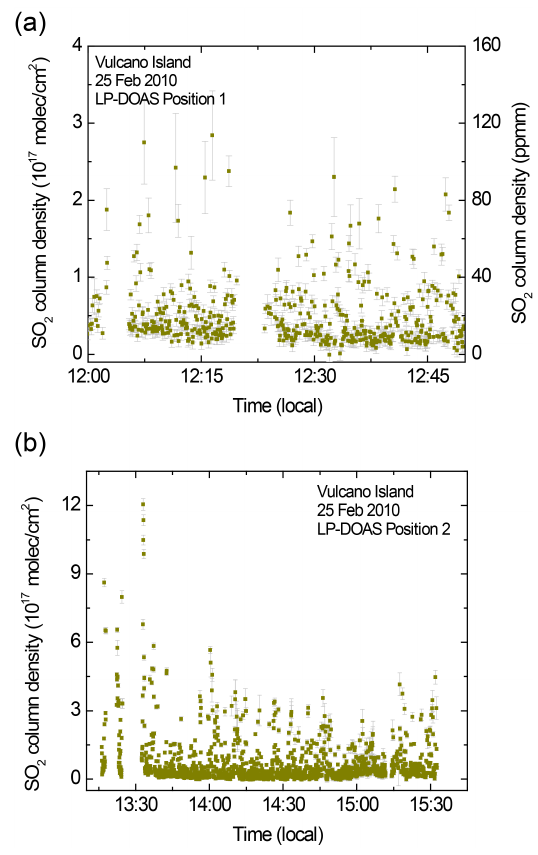
Figure 5. Time series of SO 2 column densities measured in the two experiments at the island of Vulcano on 25 February 2010. (a) depicts the results obtained during the first measurement pe- riod at a low-temperature fumarole on the crater rim, and (b) de- picts the results obtained while measuring gas stemming from the fumaroles along the base of the crater during the second measure- ment period. Rapid fluctuations in column density arise from var- ious amounts of gas being blown into the optical path of the LP- DOAS